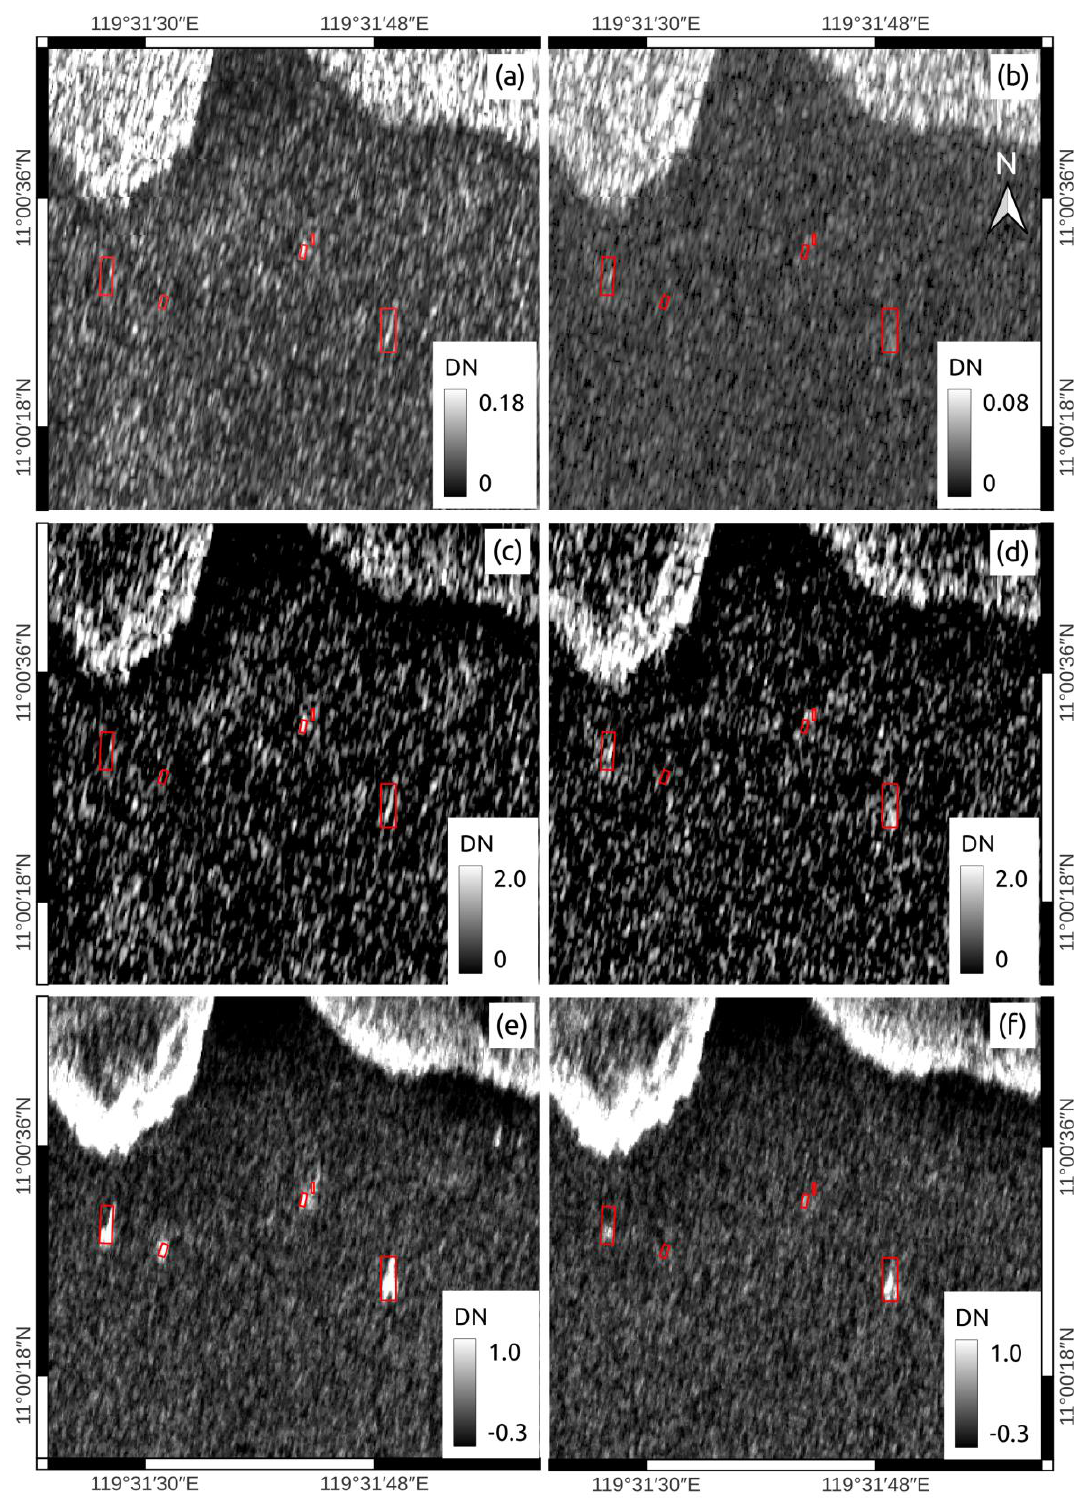
Figure 5. Composition of multiple Sentinel-1 SAR scenes: original SAR image at ( a ) VV and ( b ) VH polarisation; ( c ) VV and ( d ) VH polarisation images at the output of contrast box detection filter; ( e ) VV and ( f ) VH polarisation median composite images. The brightness of each point indicates the backscatter amplitude digital number (DN).